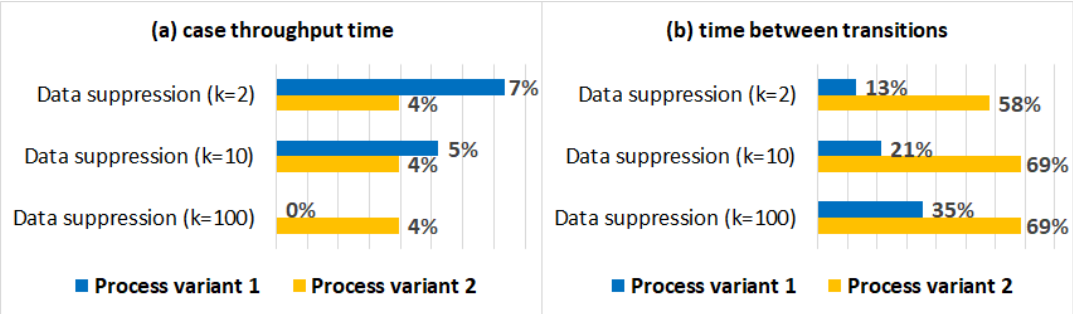
Figure 9. The impact of data suppression on the performance of different process variants: ( a ) the absolute percentage differences between the average case throughput time in the original log and the anonymised logs, and ( b ) the absolute percentage differences between the average times between activities in the original log and the anonymised logs (for process variant 1 and process variant 2).